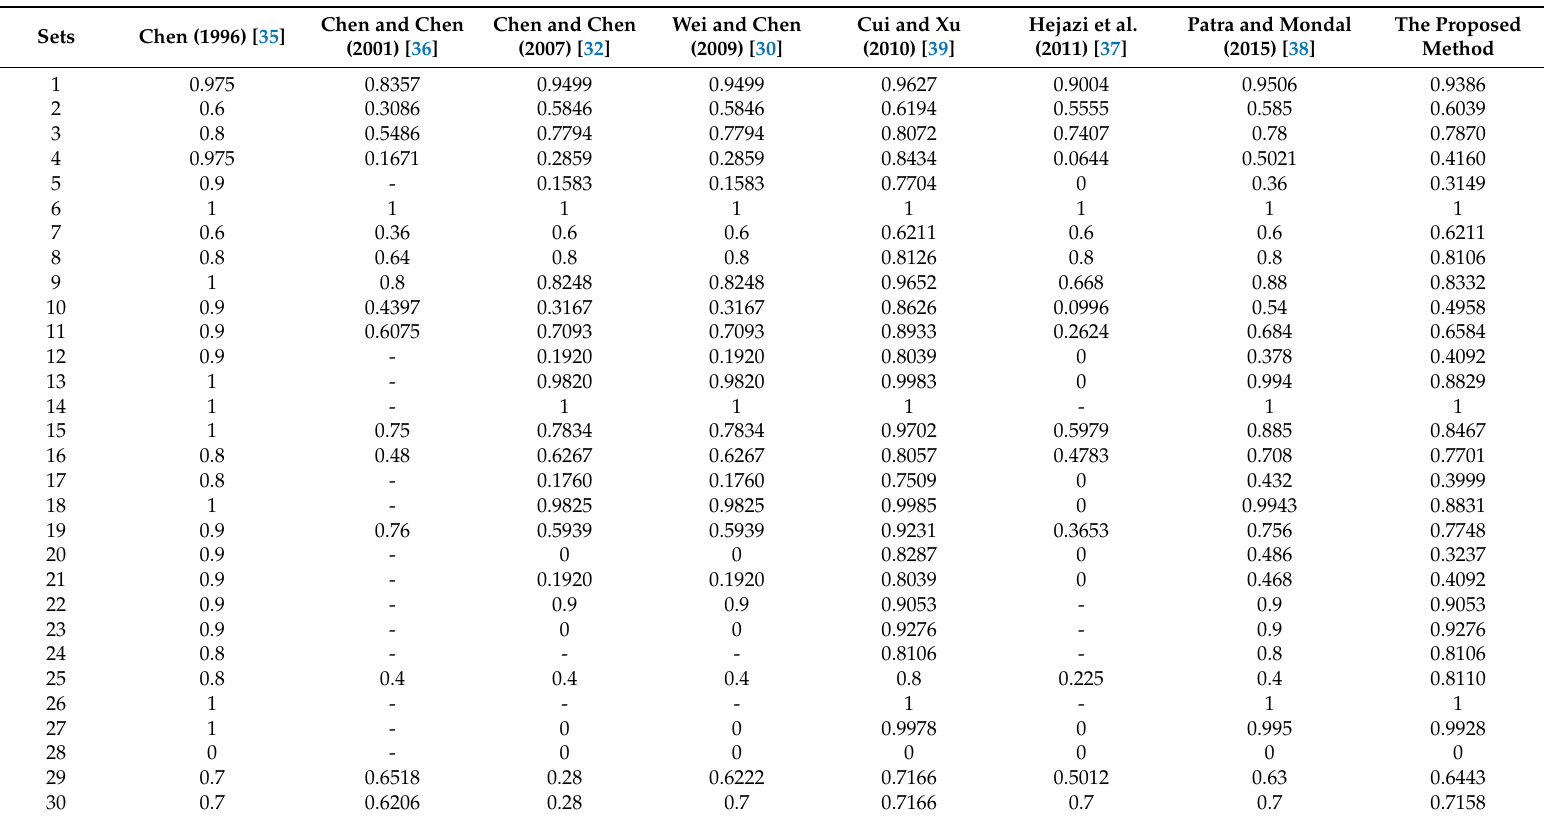
Table 1. Comparative analysis of the calculation